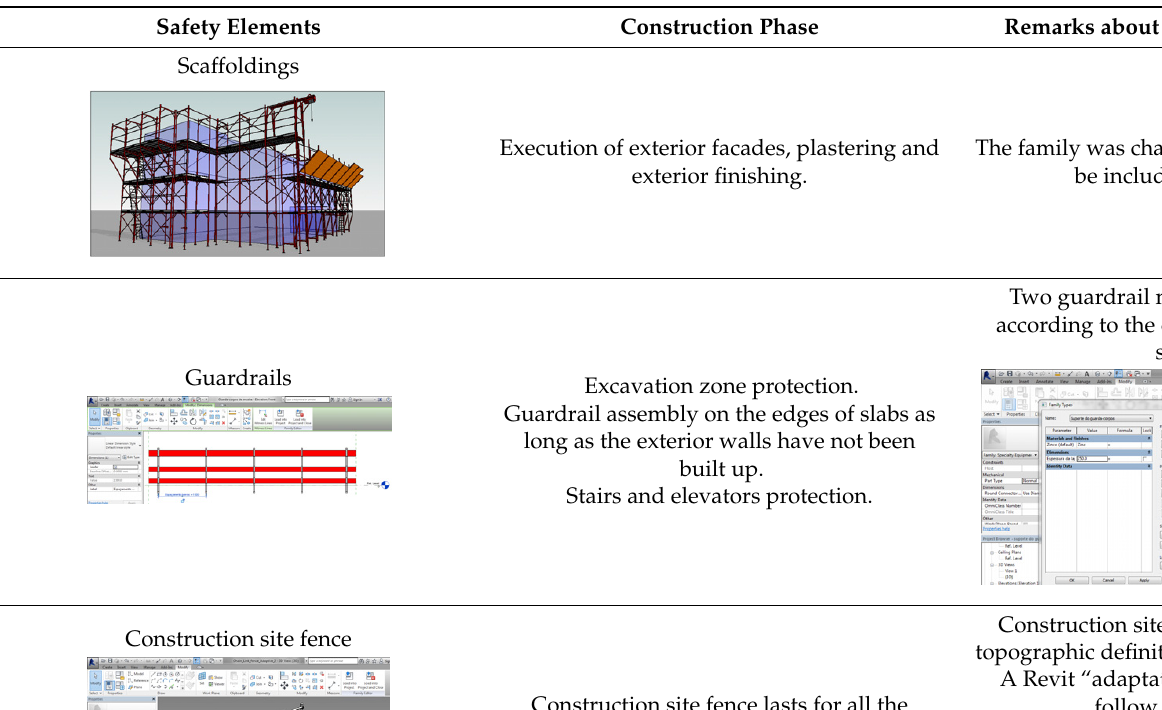
Table 1. Assembly and disassembly of temporary structures according to the work sequence.